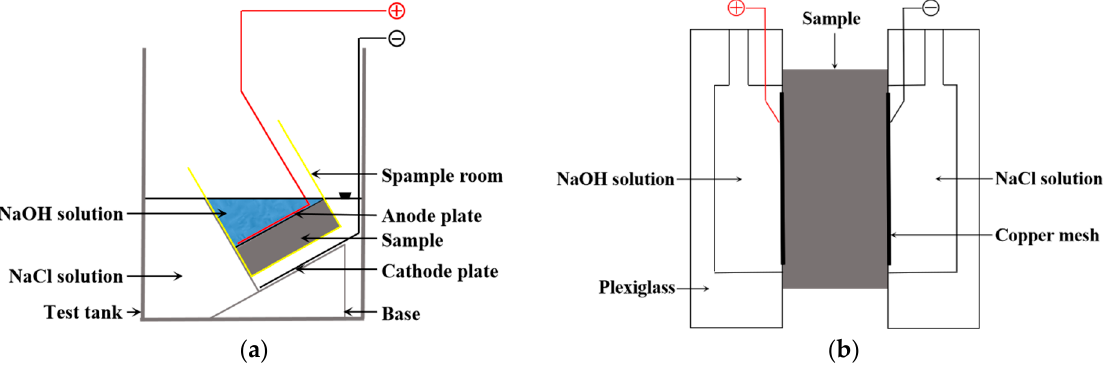
Figure 1. Schematic diagram of sample resistance to chloride ion penetration test; ( a ) electric flux method; ( b ) RCM. Table 5. Test methods for resistance to chloride ion penetration.